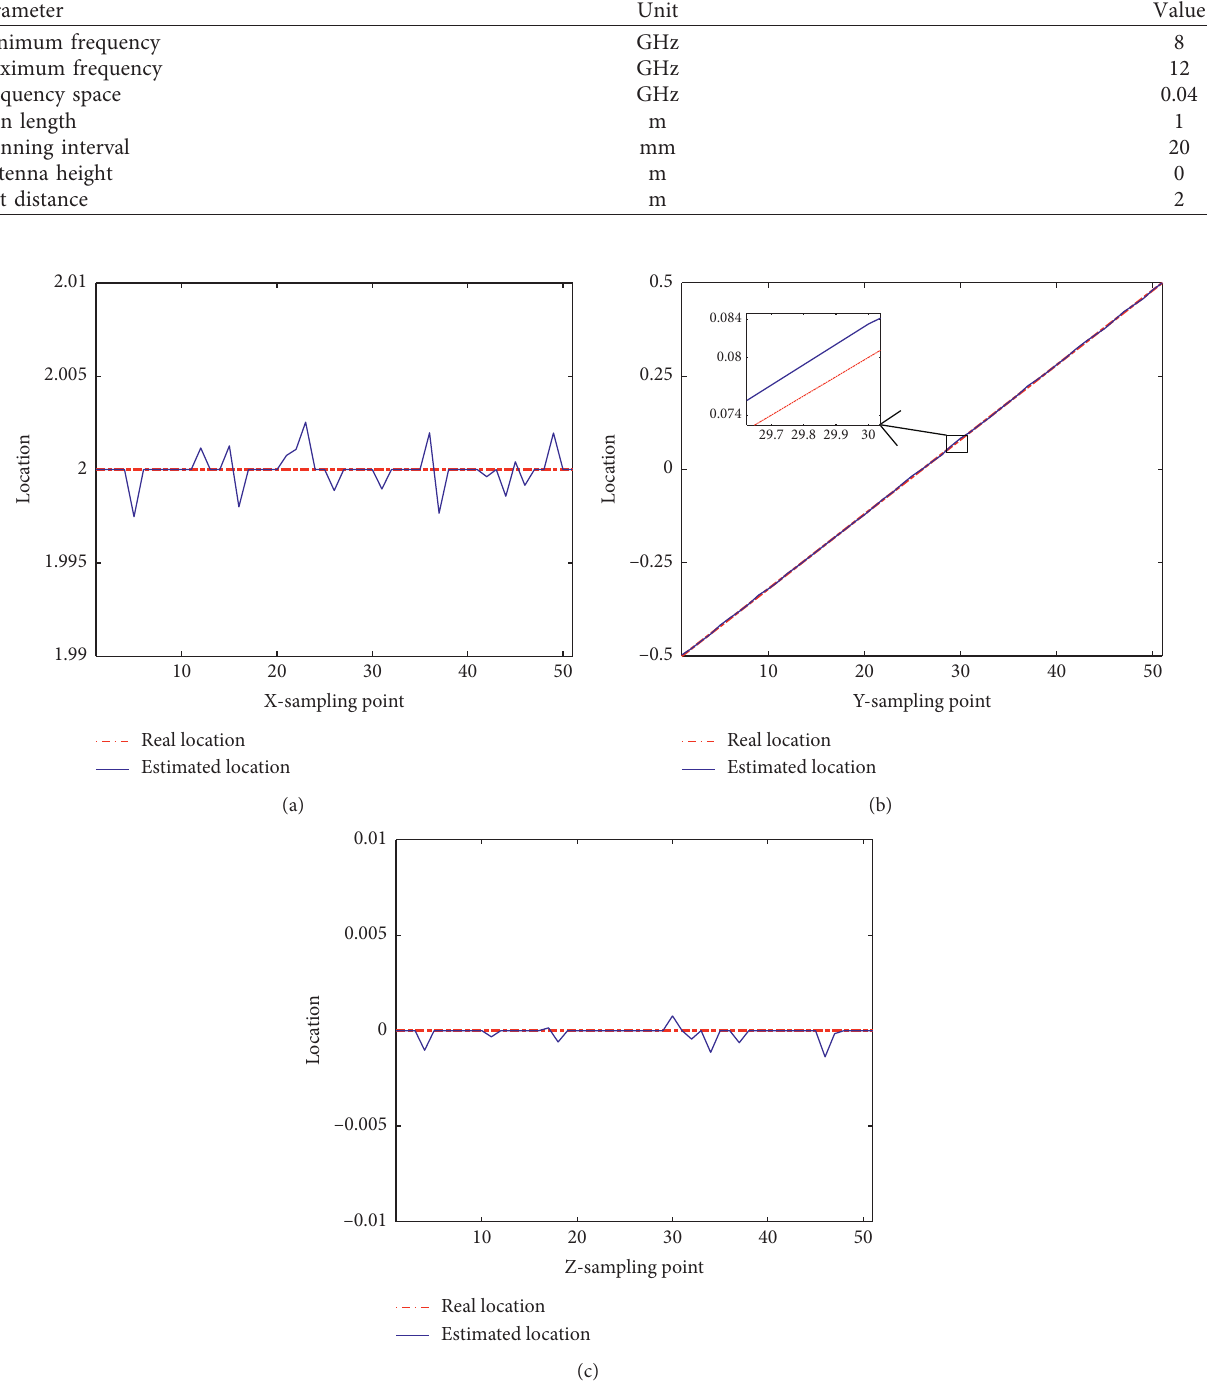
Figure 13: Estimation results of observation position. (a) x coordinates. (b) y coordinates. (c) z